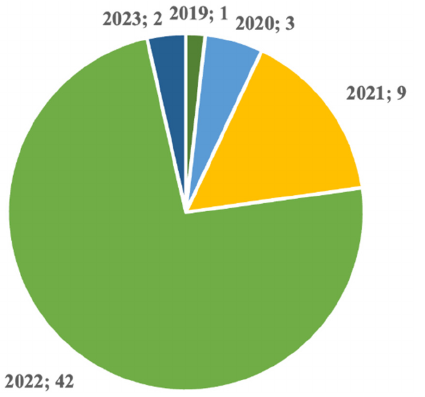
Figure 2. Number of articles published by year (Year; Number of publications).